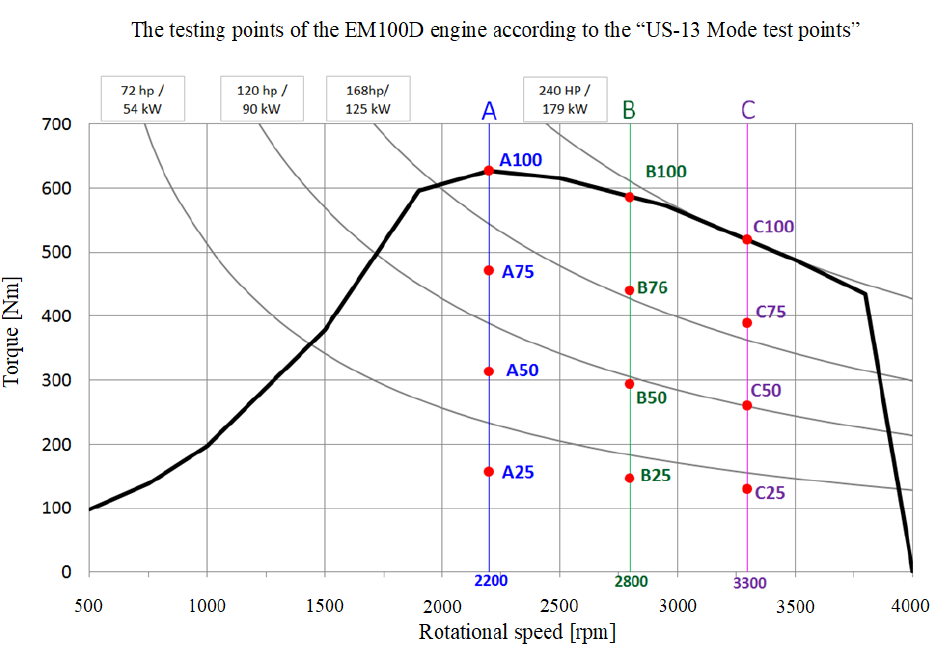
Figure 5. The testing points of the EM100D engine. Table 2. The engine’s parameters in the testing points for US-13 Mode testing cycle. Testing